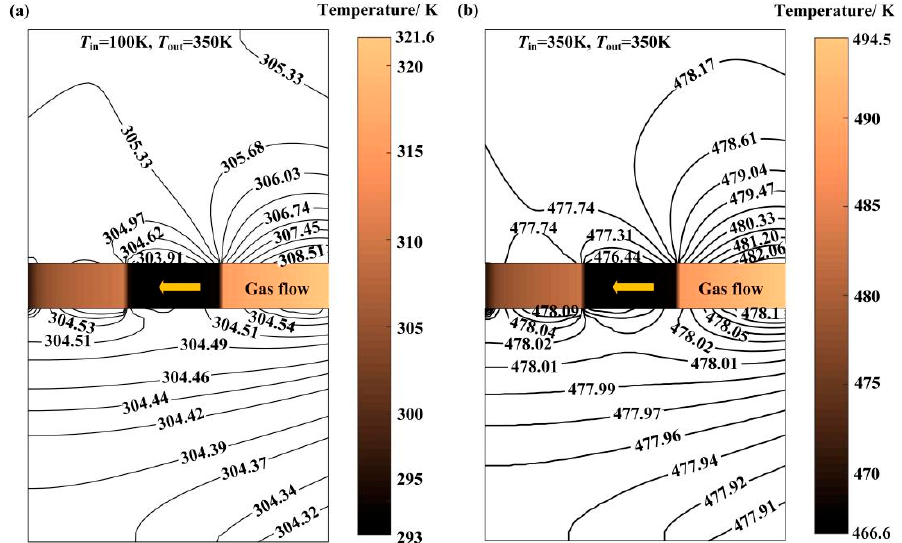
Figure 3. Cross-sectional temperature distributions of the spiral-grooved face seal (The color legend only applies to the gas film). ( a ) Temperature gradient condition; ( b ) Isothermal condition. ( P in = 5.0 MPa, P out = 0.1 MPa, n = 50,000 rpm, h 0 = 3 µ m).